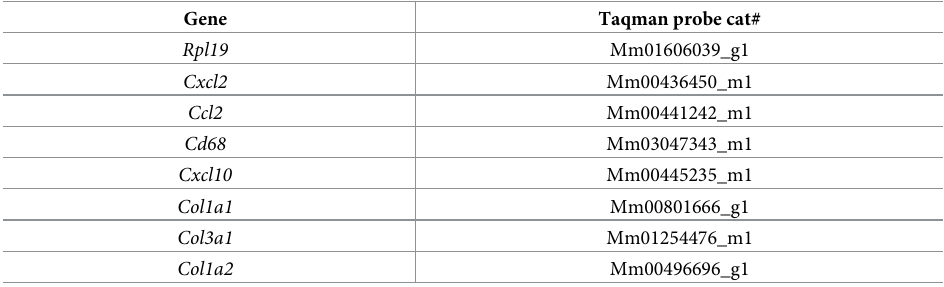
Table 1. Taqman probe